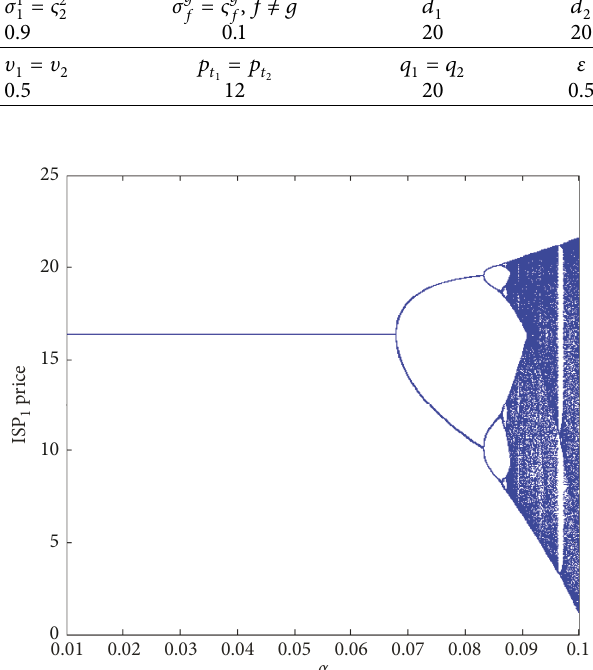
Figure 1: Bifurcation diagrams of p